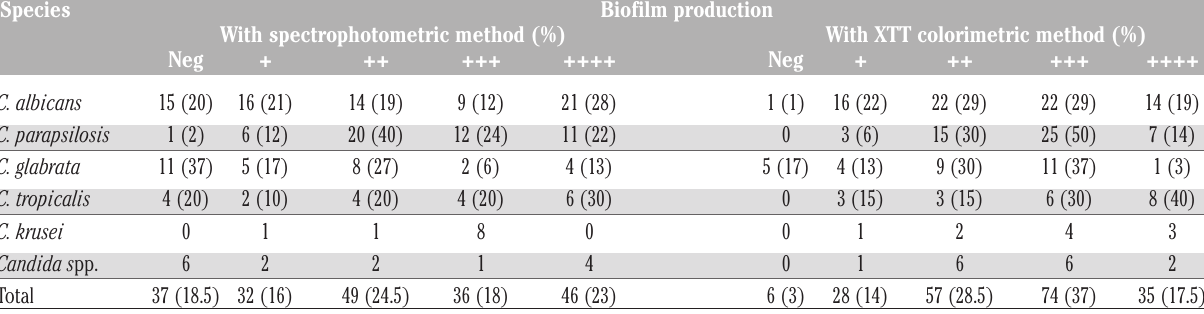
Table 1. The results of methods used for the detection of biofilm production.